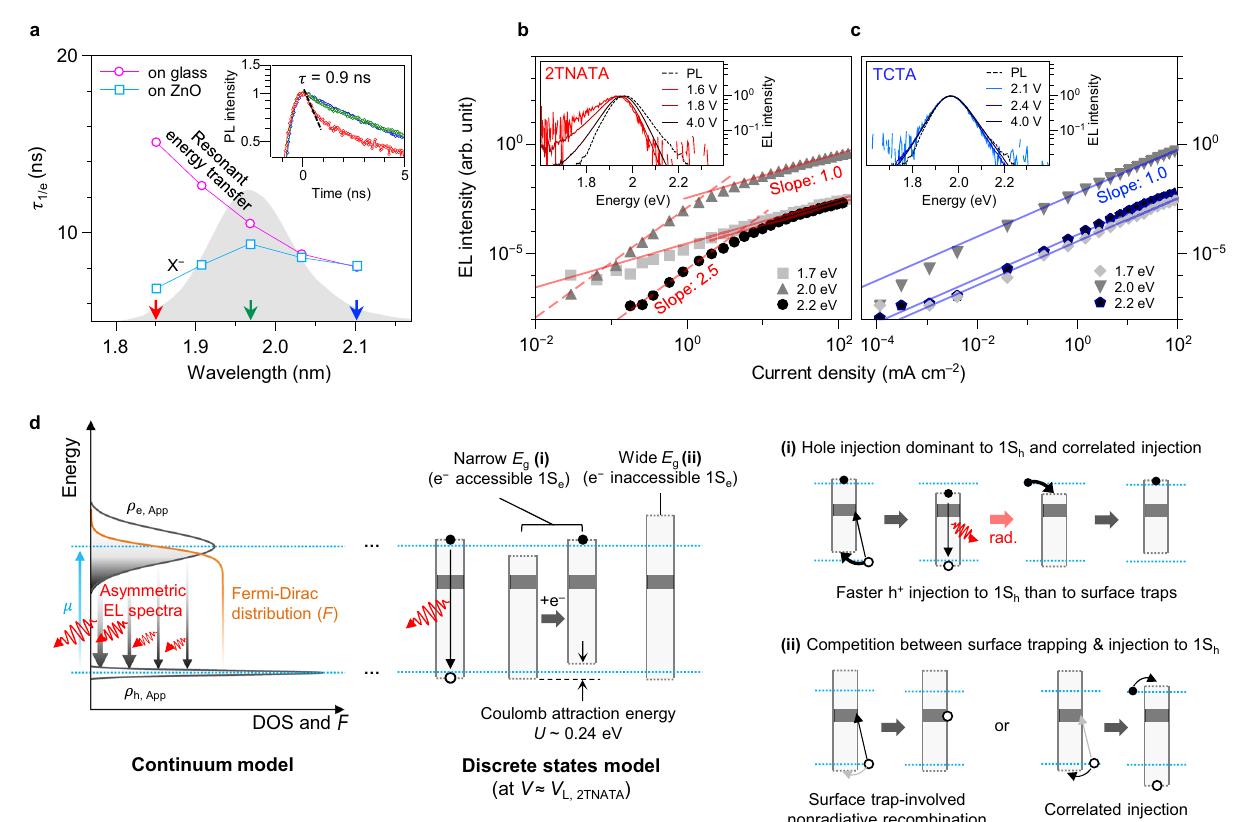
Fig. 4 Local electrostatic potential gain granted by a charge in individual QDs and discrete nature of QD emissive layer. a Spectrally resolved PL decay lifetime ( τ 1/e ) of glass/QDs (magenta circle) and ITO/ZnO/QD (sky blue square) at different wavelengths. PL spectrum of QD fi lm is provided as grey background. Inset shows PL decay traces of ITO/ZnO/QDs at 2.10, 1.97, and 1.85 eV, indicated using blue, green, and red arrows, respectively, on the x -axis of the main panel. X – decay is clearly observed at 1.85 eV with a lifetime of 0.9 ns in early stage (red). b , c EL intensity – J dependence probed at 1.7 eV (light grey square), 2.0 eV (dark grey triangle), and 2.2 eV (black circle) for 2TNATA-based ( b ) and TCTA-based QLEDs ( c ). Dashed and solid lines indicate regression lines with a slope of 2.5 and 1.0, respectively. Insets show EL spectra acquired at different biases. d Schematic illustration on continuum density of state (DOS) model. At a speci fi c electron chemical potential ( μ , sky blue line), electrons occupy the apparent 1S e DOS ( ρ e, App ) from the lowest state following the Fermi – Dirac distribution ( F ), F × ρ e, App . On the other hand, holes in the apparent 1S h DOS ( ρ h, App ) possess minimal energy distribution due to the narrowness of ρ h, App . Spectral shape is therefore determined by the distribution of F × ρ e, App in energy scale that shows low-energy tail. e In the microscopic viewpoint, individual QDs experience different electron occupation, and carrier injection events. In 2TNATA-based QLEDs, at V ≈ V L , prior injection of an electron into narrow- E g QDs results in prompt injection of a hole via Coulombic attraction ( U ) [(i), upper right]. In the case of wide- E g QDs, a hole is likely to migrate to 1S h state or to surface states. Barring the unlikely event that the hole introduced to 1S h state electrostatically attracts an electron, the trap-involved nonradiative recombination is